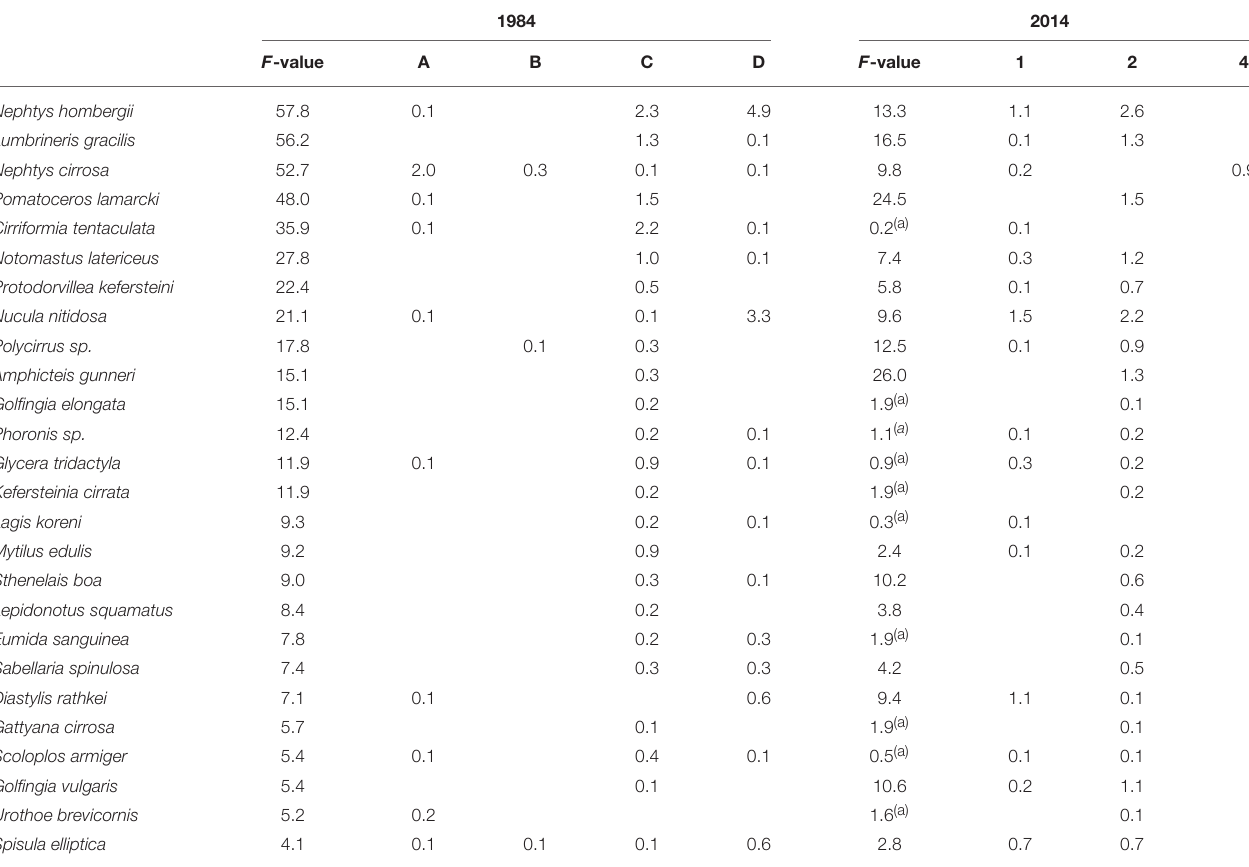
TABLE 3 | Indicator species of sample clusters in 1984 and 2014 (Figure 2) determined by pseudo F